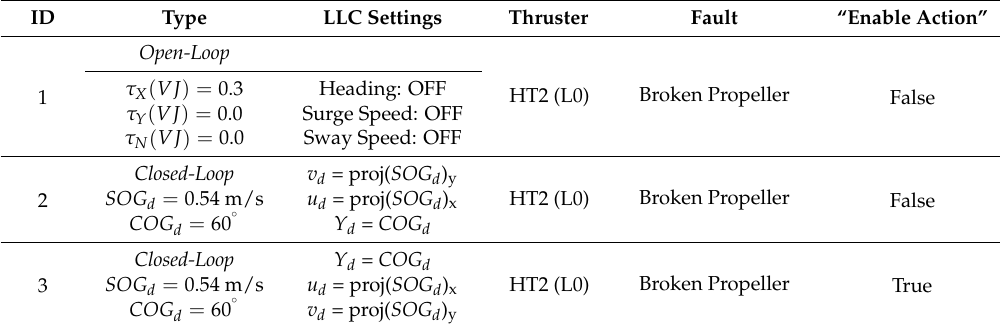
Table 10. Description of simulation